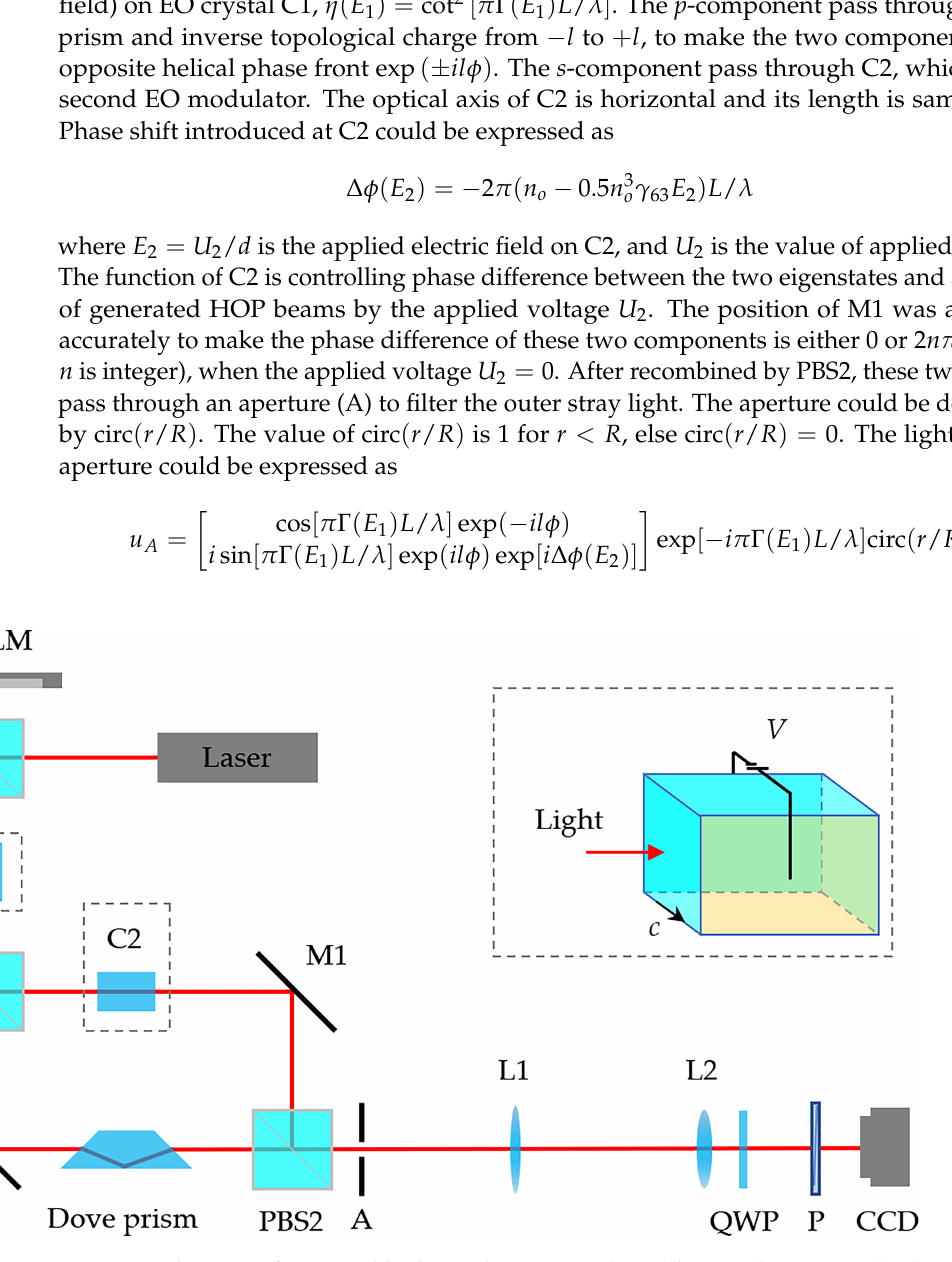
Figure 1. Schematic of proposed higher-order Poincaré (HOP) beams electro-optic (EO) modulation system. The dotted box in upper right corner shows the diagram of applying voltage to EO